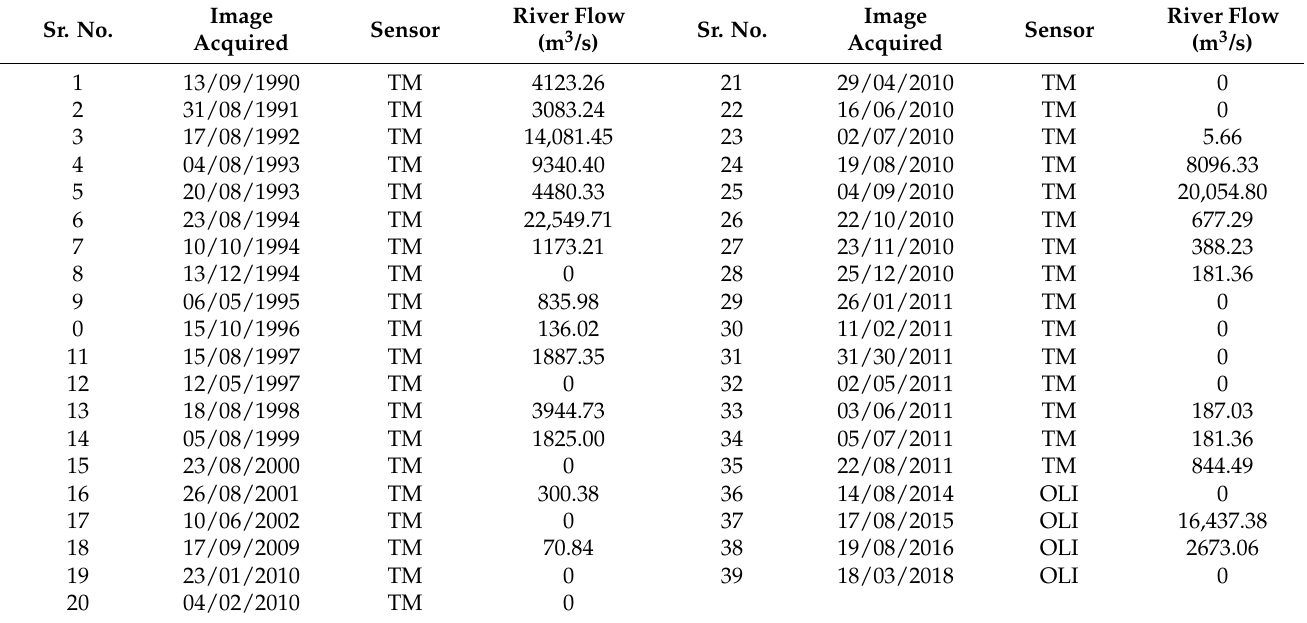
Table 1. Detail of satellite imageries processed for detection of surface water extent corresponding to